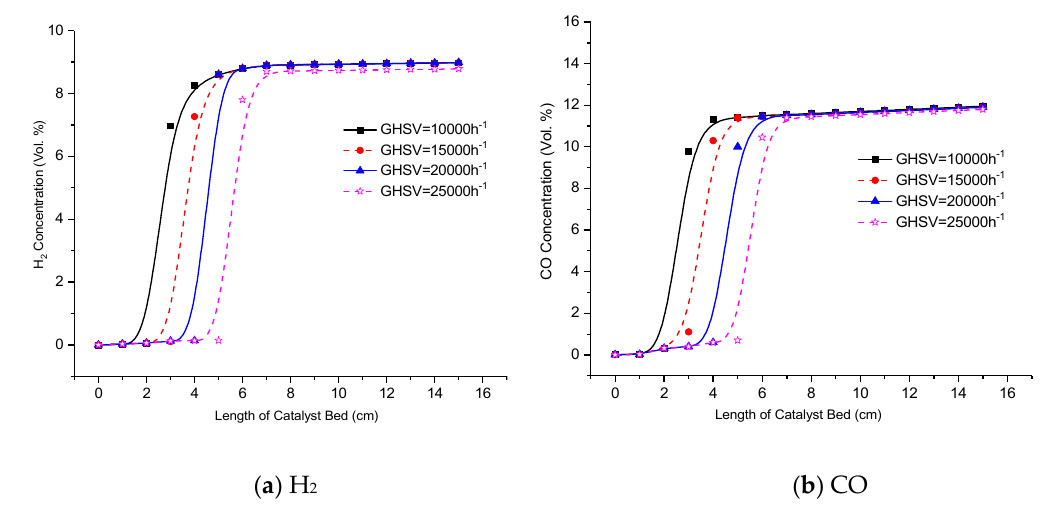
Figure 4. GHSV e ff ect on H 2 and CO concentration. Figure 4. GHSV effect on H 2 and CO concentration. Figure 4. GHSV effect on H 2 and CO concentration.